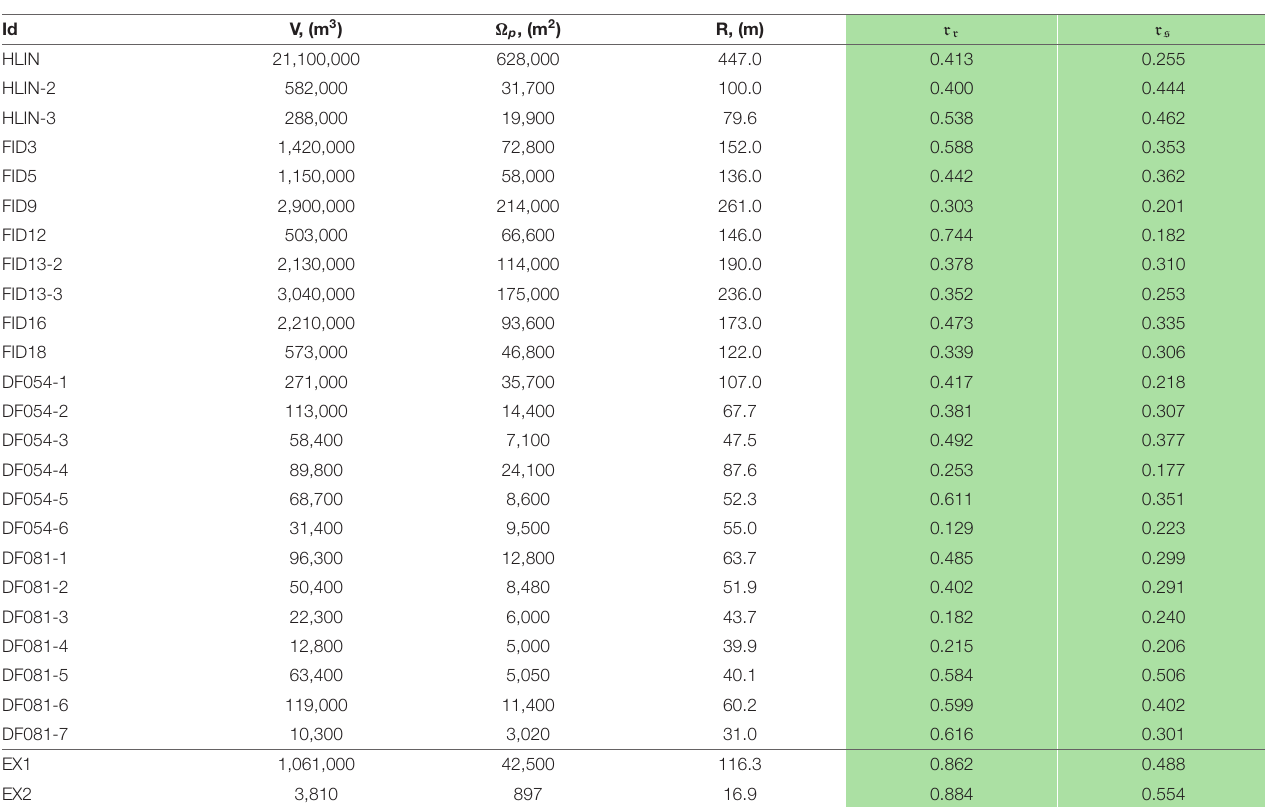
TABLE 1 | Landslide volume, area, equivalent radius, roundness, and sphericity.